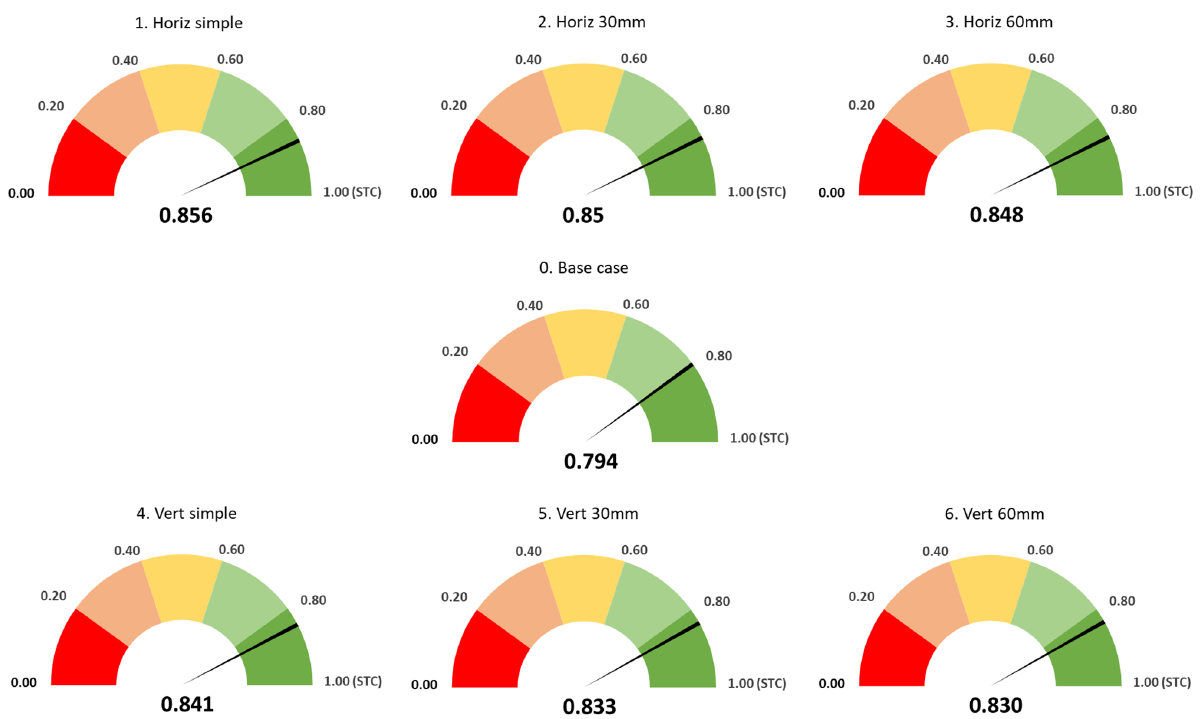
Figure 12. Normalized power production for front wind , v front = 1 m/s, t air = 35, G = 1000 W/m 2. . Even if the highest energy production is obtained in the case of the wind direction behind the panel, for the horizontal heat sink with perforated fins, it should be specified that the most important impact in terms of cooling compared to the base case is recorded when the wind blows from the side.